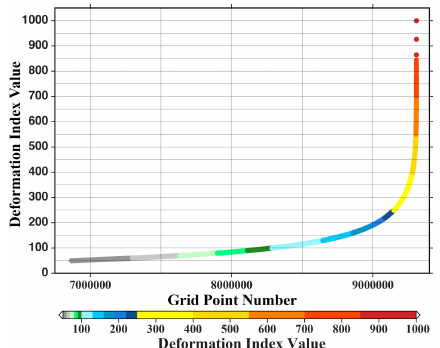
Figure 13. Deformation index values sorted lowest to greatest value vs. sort point number. Note that more than the first 6 million values have values less than 50, and that accounts for the white areas in Fig.